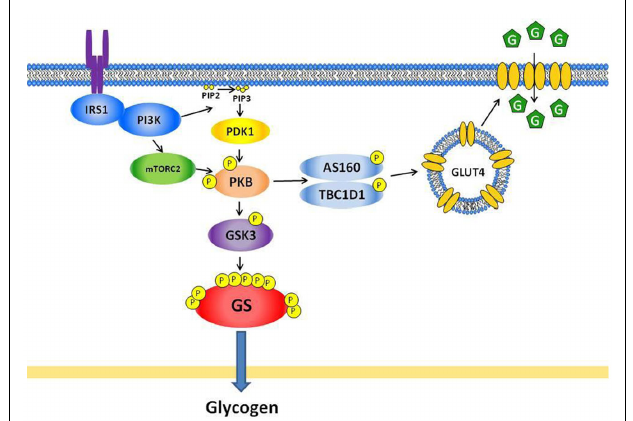
FIGURE 1 | Insulin signaling pathways regulating glucose transport and glycogen synthase in skeletal muscle. Insulin activates protein kinase B (PKB) through phosphatidylinositol 3-kinase (PI3K) and two upstream kinases; namely phosphoinositide-dependent protein kinase-1 (PDK1; phosphorylates PKB at threonine 308) and the mammalian target of rapamycin complexed with Rictor (mTORC2; phosphorylates PKB at